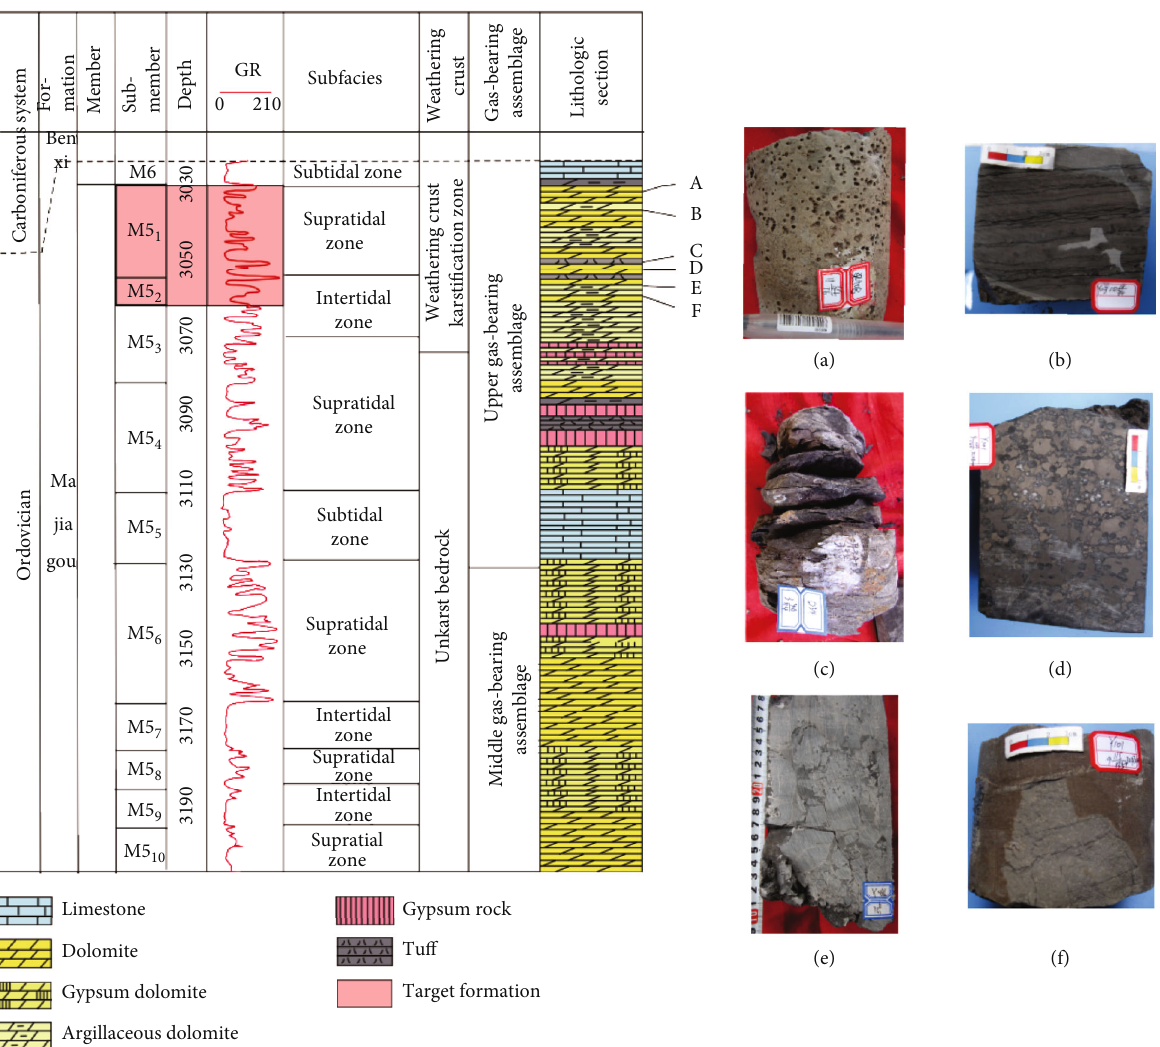
Figure 2: Stratigraphic and lithology histogram of the Yan ’ an gas fi eld with photographs of the representative lithology of the gas fi eld: (a) anhydrite-bearing mud powder crystal dolomite, (b) algal dolomite, (c) tu ff , (d) fully fi lled anhydrite-bearing mud powder crystal dolomite, (e) karst breccia, and (f) fracture developed fi ne-powder crystal